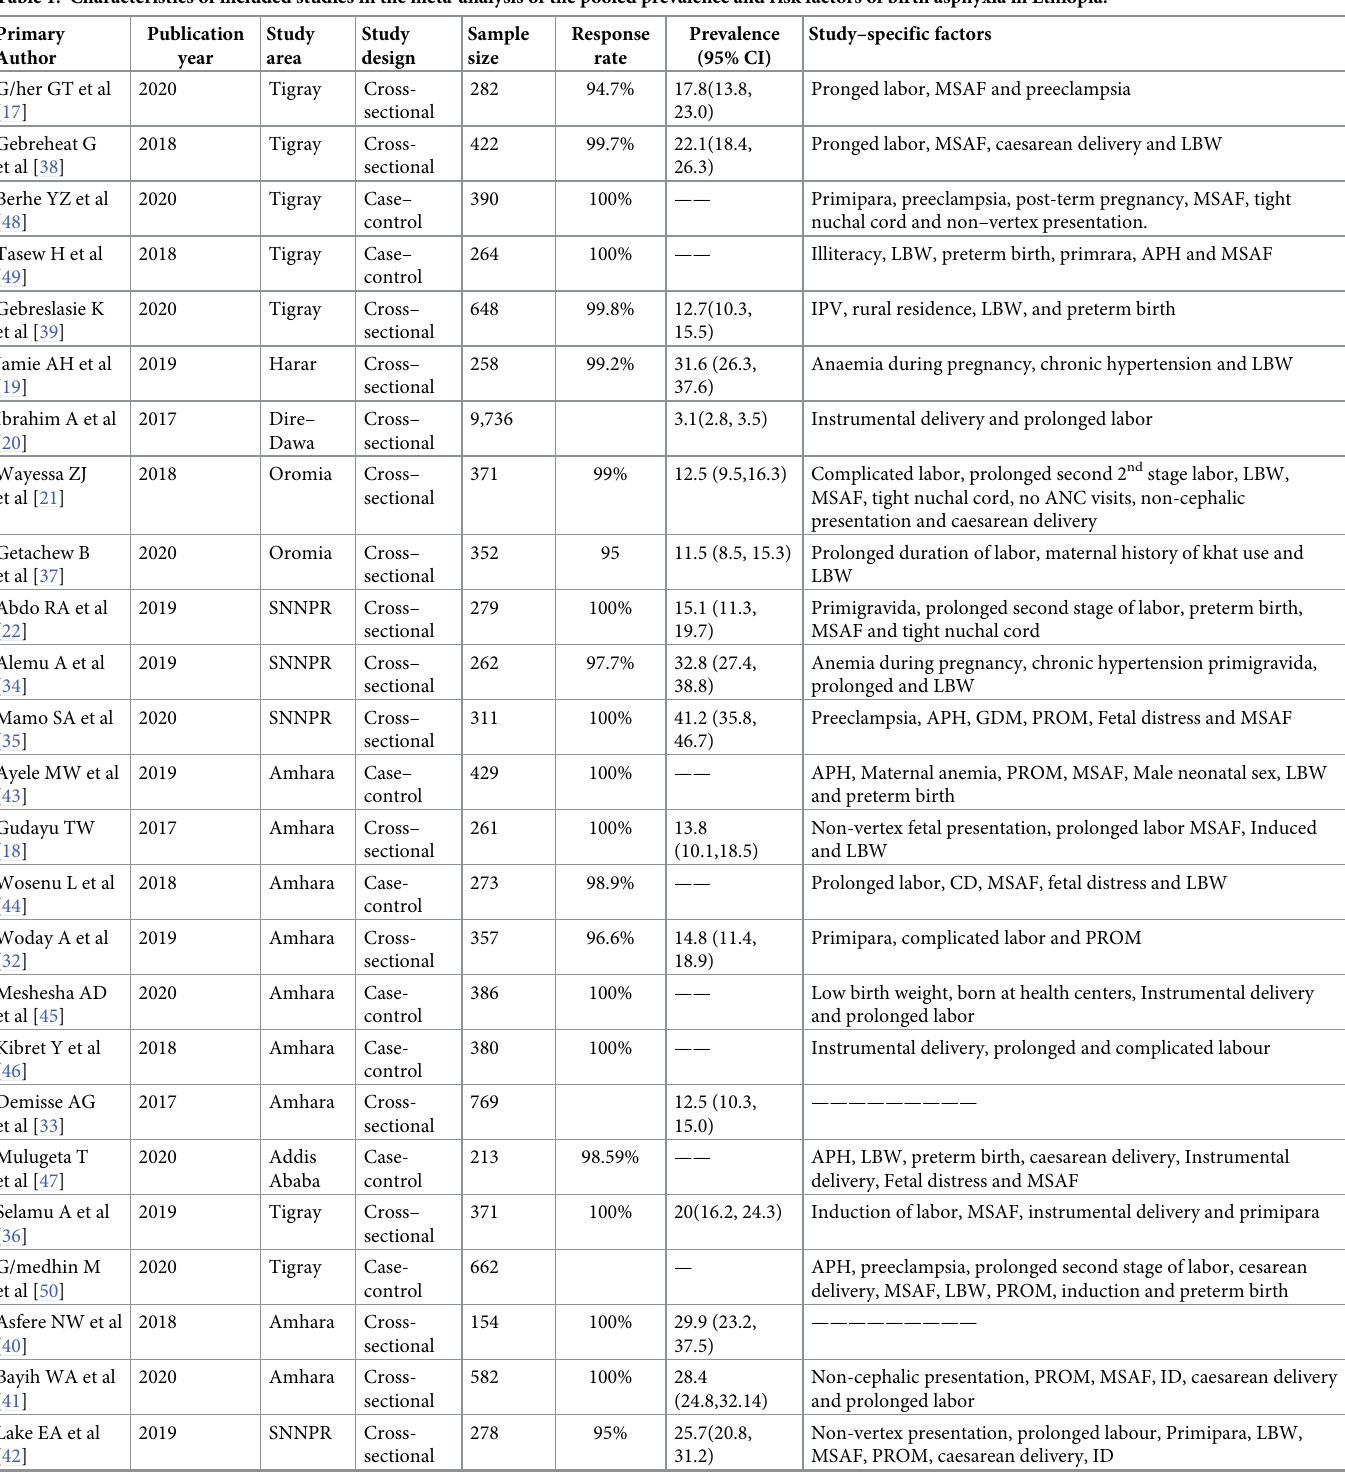
Table 1. Characteristics of included studies in the meta-analysis of the pooled prevalence and risk factors of birth asphyxia in